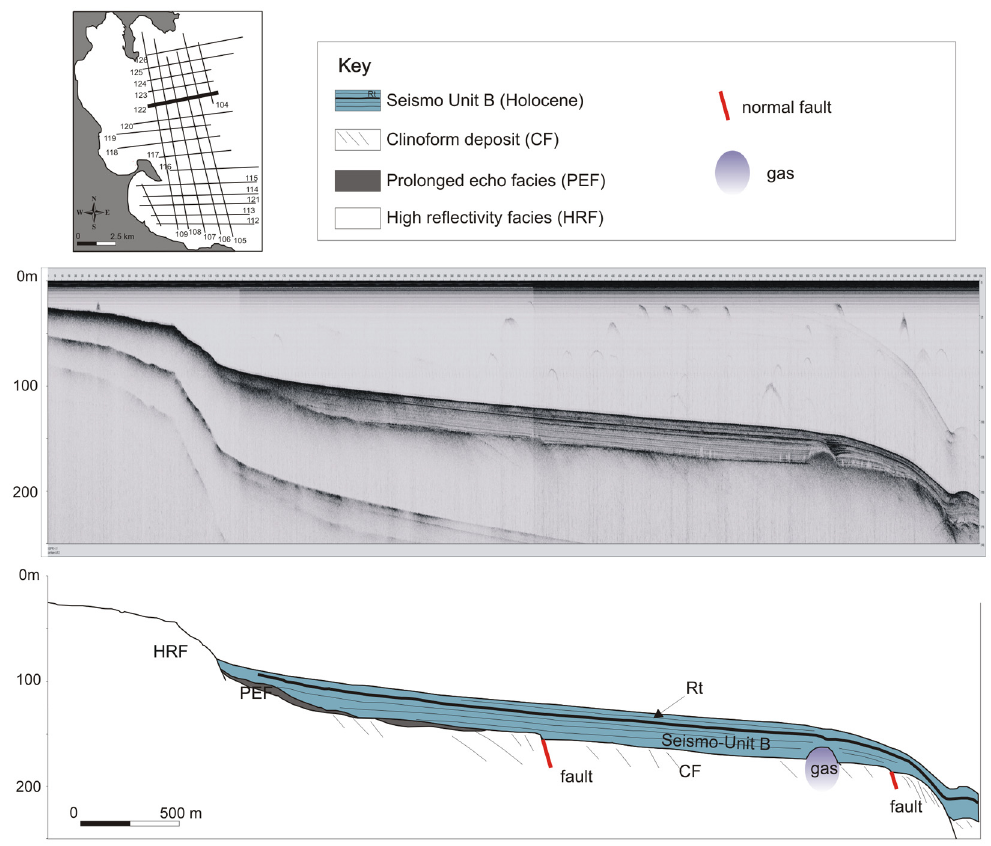
Figure 6. Chirp profile 122 showing the main Augusta basin features and their seismo-stratigraphic